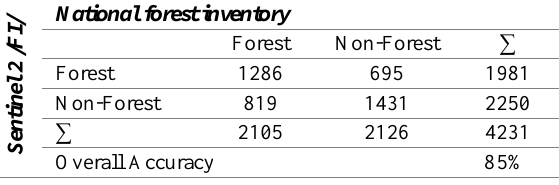
Table 4. Confusion matrix and accuracy estimates